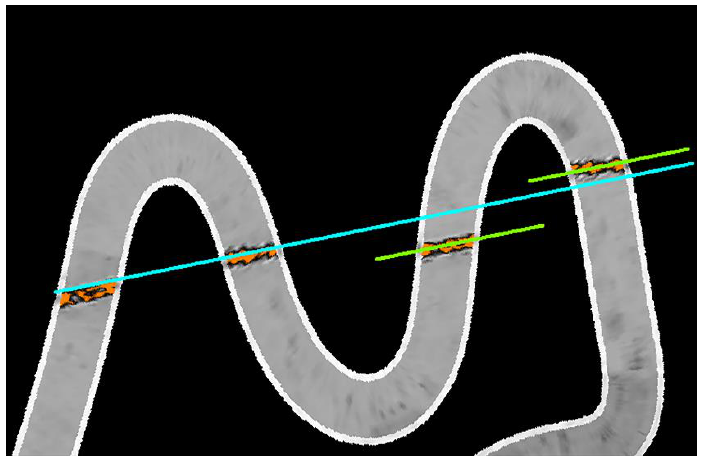
Figure 11. Resulting C-scan of irregular pass positioned with the use of total station with the axis of the drainage grille in the background.